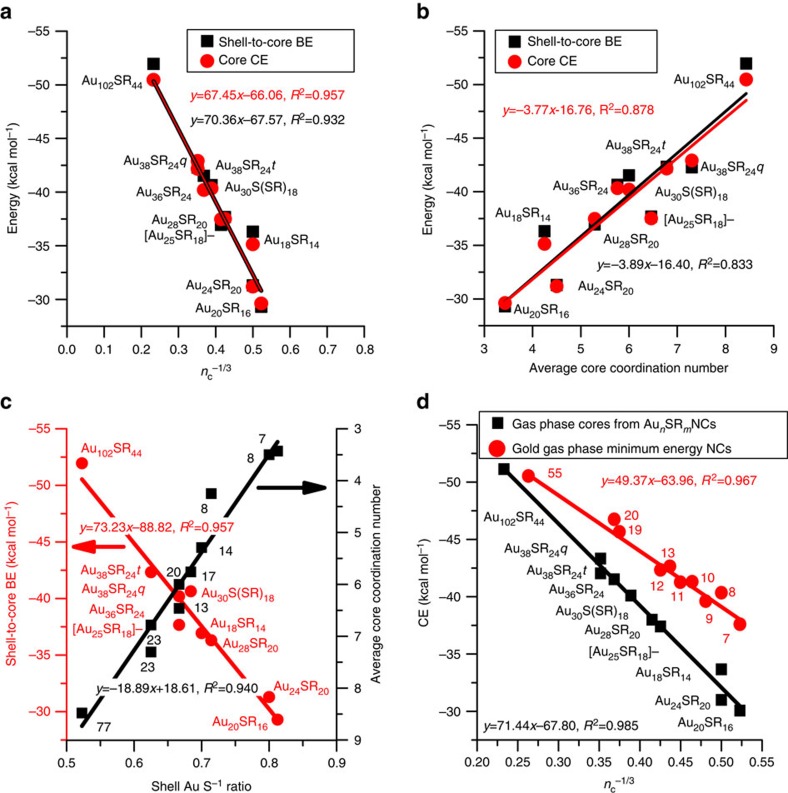
Nanocluster stability–morphology relations.(a) Core CE and shell-to-core BE versus nc−1/3 (number of core metal atoms) for cores of thermodynamically stable magic number Au NCs. (b) Core CE and shell-to-core BE versus average coordination numbers (CNs) for cores of Au NCs. (c) Shell-to-core BE and average core CN versus the ratio of total Au atoms and S atoms in the shells and (d) global minima gas phase Au clusters and cores of Au NCs. From Figs 1 and 2, the Au NC cores contain: Au18SR14=8, Au20SR16=7, Au24SR20=8, [Au25SR18]−=13, Au28SR14=14, Au30S(SR)14=17, Au36SR24=20, Au38SR24q,
t=23 and Au102SR44=77 Au atoms.